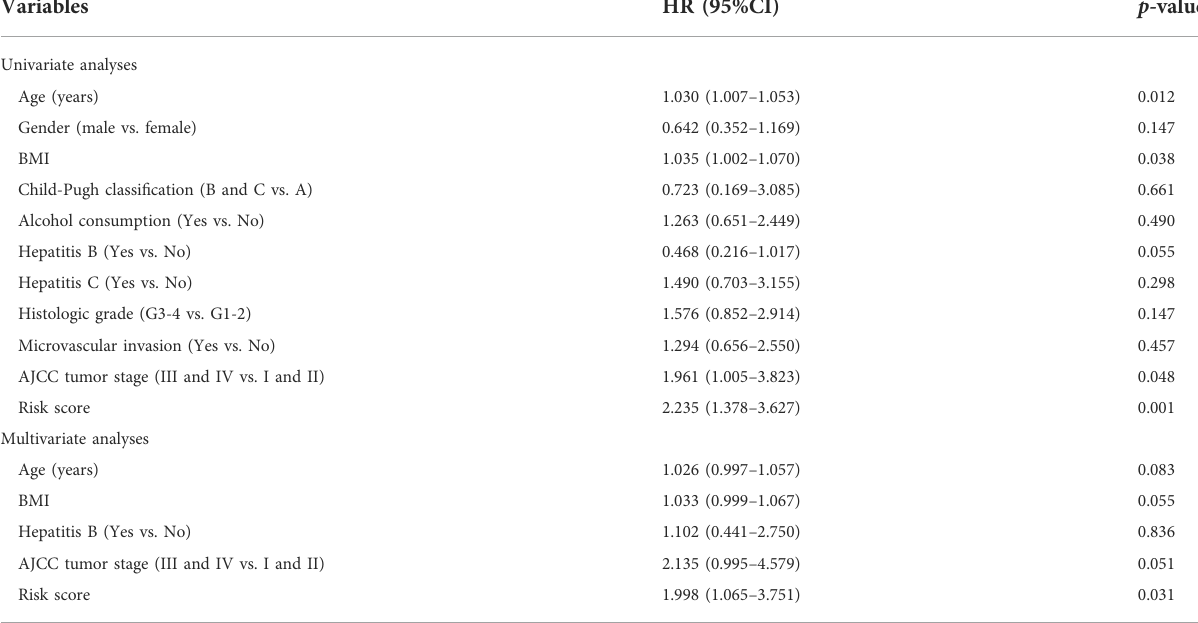
TABLE 5 Univariate and multivariate analyses of risk factors in the validation